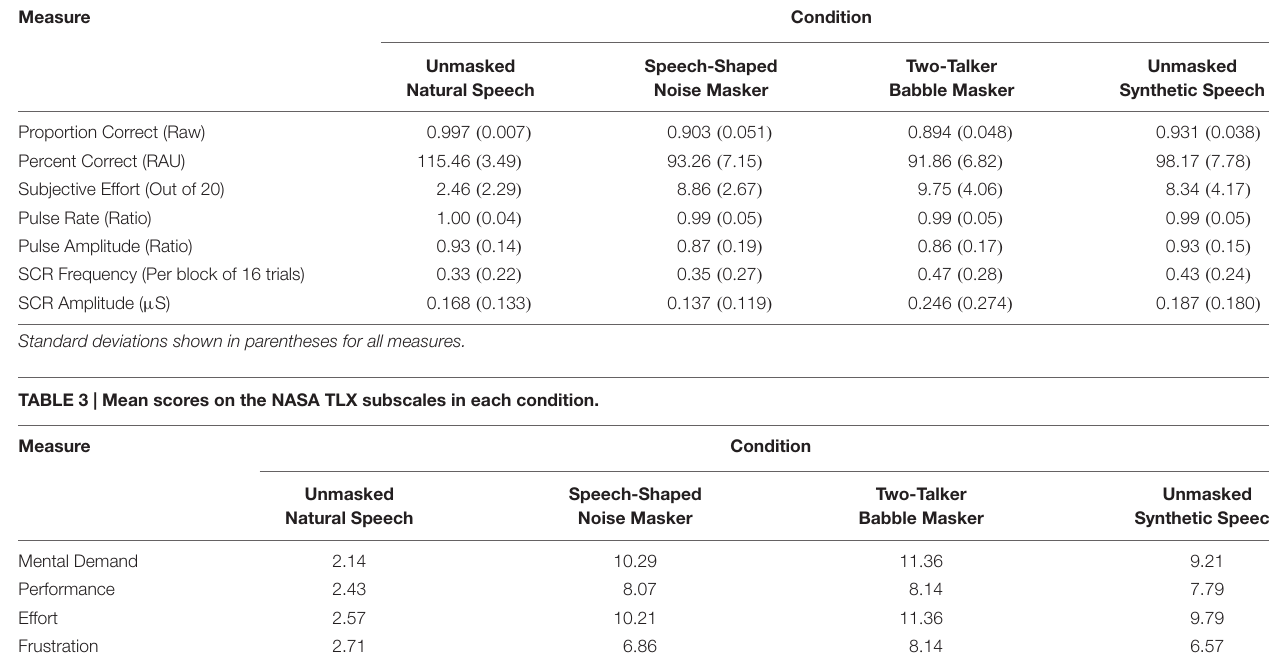
TABLE 2 | Behavioral and physiological measures obtained for each condition.